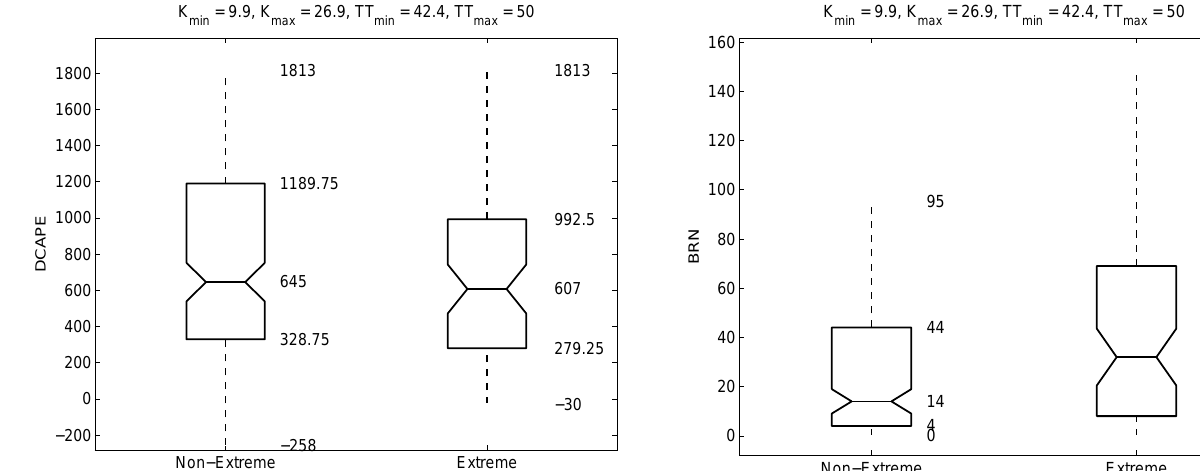
Fig. 6. The distribution of the values of the BRNsh index for the days where extreme (right) and non-extreme (left) events occurred.